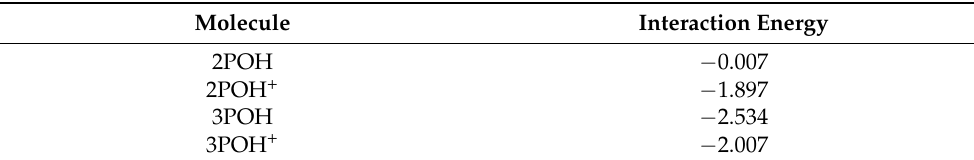
Table 1. Interaction energies of neutral and protonated pyridine oximes adsorbed on a Fe(110) surface obtained by SCC-DFTB simulations (in eV). Molecule